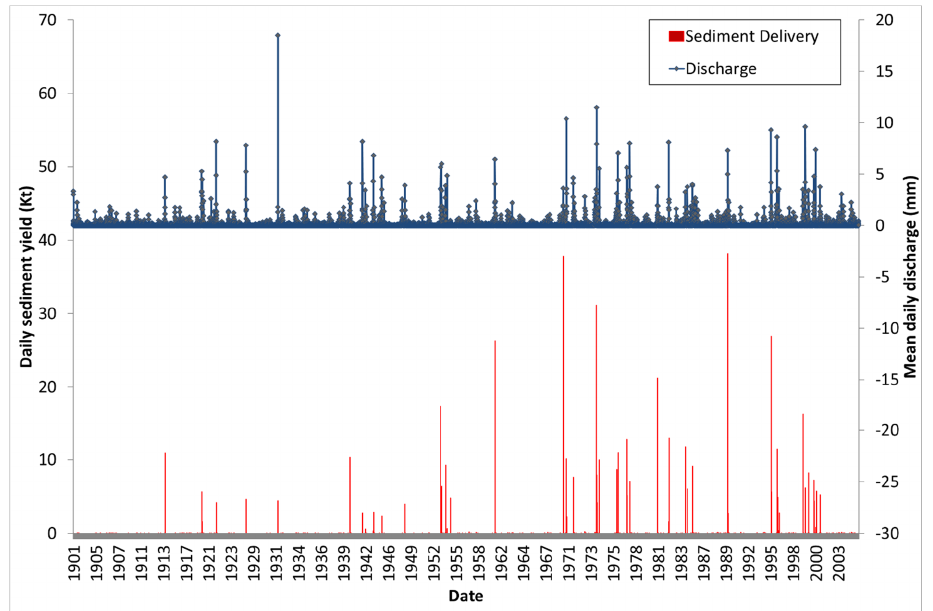
Figure 7. A comparison of daily sediment yield and discharge outputs for the Cranemere catchment.